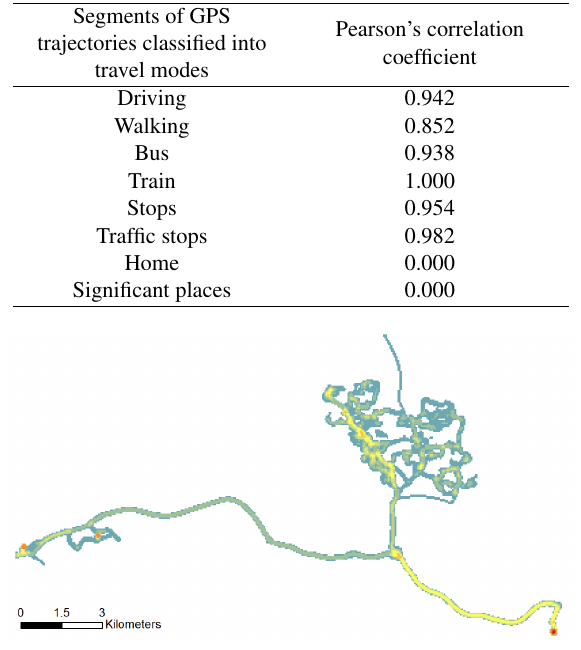
Figure 6: Trajectory generalisation - KDE for line segments de- rived from GPS trjectories. Kernel bandwidth 100m for the cell 50m. Trajectory without anonymised significant locations.